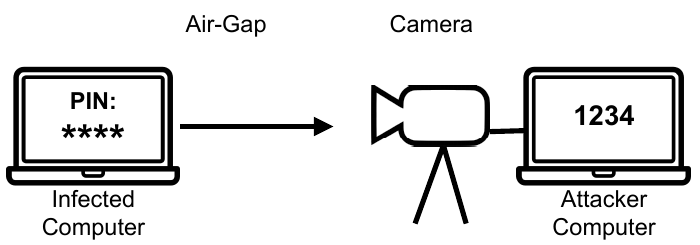
Figure 1. Scheme of the attack using air gap video